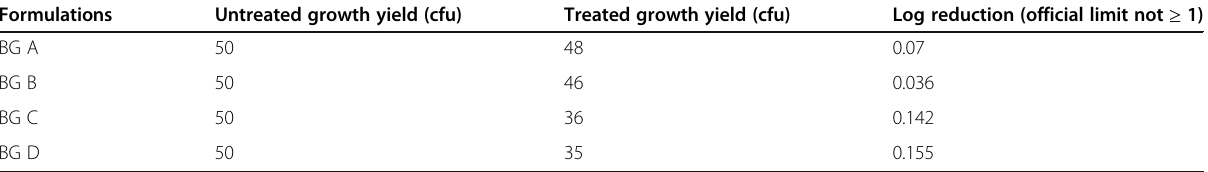
Table 4 Lactobacilli crispatus viability testing of tenofovir and maraviroc bigel formulations